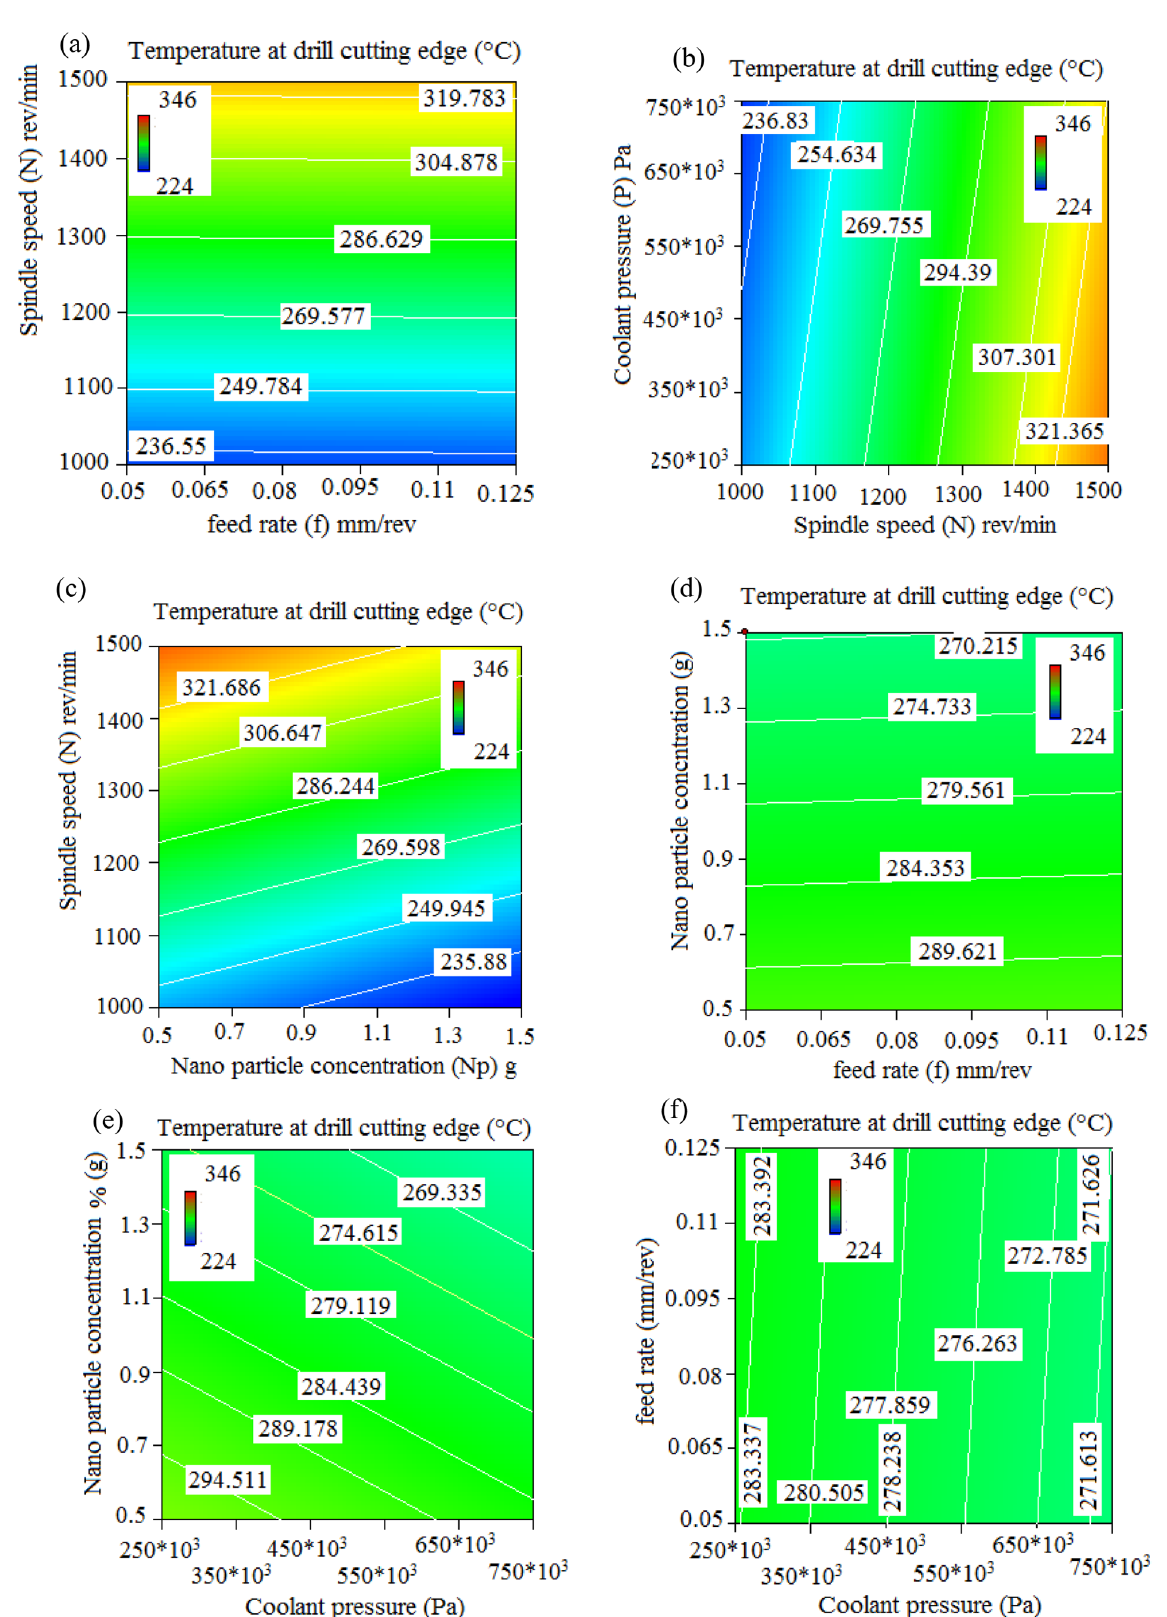
Fig. 6. (a-f) Effect ’ s of process parameters on ‘ Q ’ , (a) Effect of ‘ N ’ at various ‘ f ’ on ‘ Q ’ , (b) Effect of ‘ N ’ at different ‘ P ’ on ‘ Q ’ (c) Effect of ‘ N ’ at different ‘ Np ’ on ‘ Q ’ (d) Effect of ‘ f ’ at different ‘ Np ’ on ‘ Q ’ (e) Effect of ‘ P ’ at different ‘ Np ’ on ‘ Q ’ (f) Effect of ‘ f ’ at different ‘ P ’ on ‘ Q ’